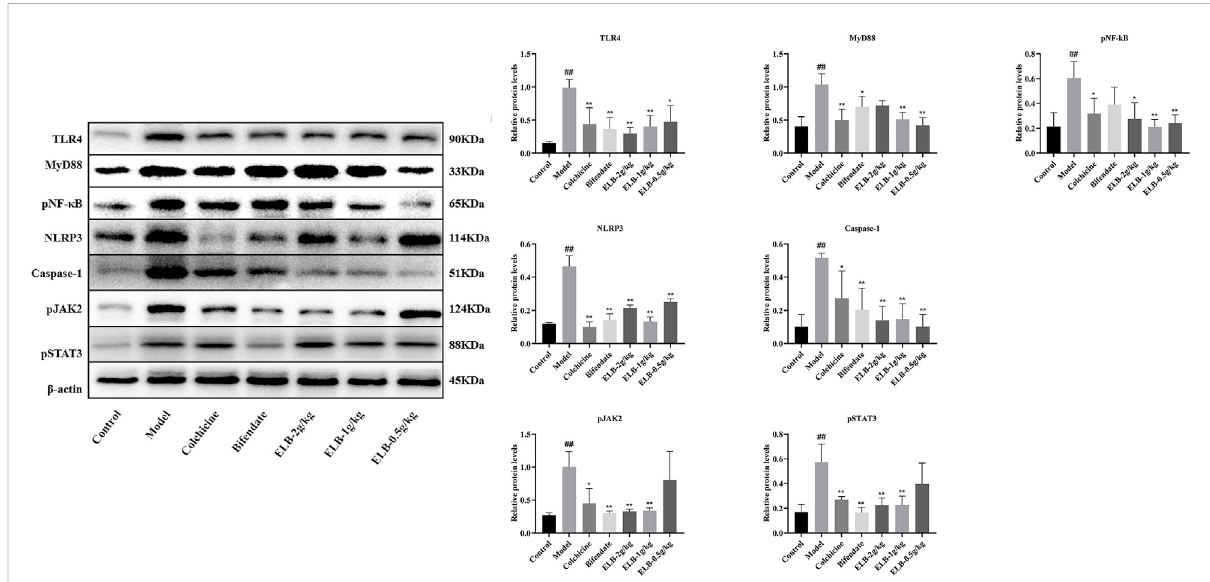
FIGURE 5 Effects of ELB on protein levels of TLR4, MyD88, pNF- κ B, NLRP3, caspase-1, pJAK2, and pSTAT3 in the synovial tissue of a rat model with chronic alcoholic liver injury and gouty arthritis. Note: compared with control group, # p < 0.05, # # p < 0.01; Compared with the model group * p < 0.05, ** p <